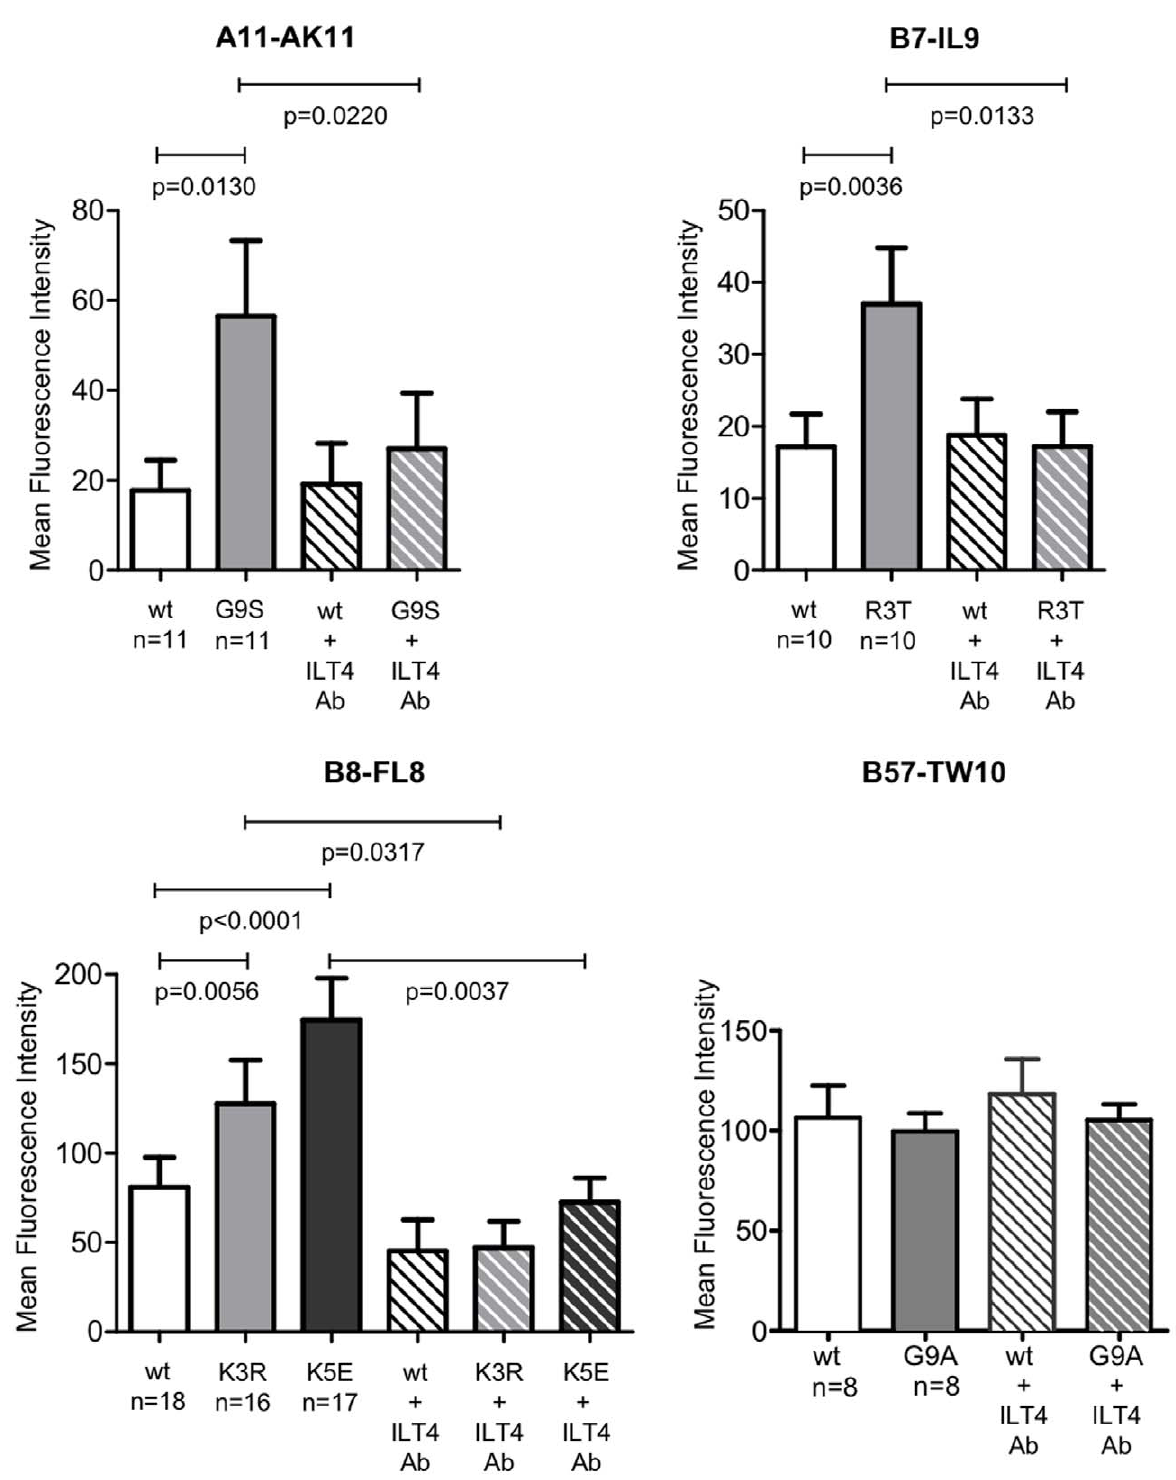
Figure 2. HIV-1 CTL escape mutations increase recognition of peptide/MHC class I complexes by the inhibitory myelomonocytic MHC class I receptor ILT4 on monocytes. Data represent the mean fluorescent intensity of MHC class I tetramers/pentamers refolded with the indicated epitopic peptide or peptide variant. Tests were performed in the indicated number of individuals. Data show mean and standard deviation. Significance was tested using paired t-test.